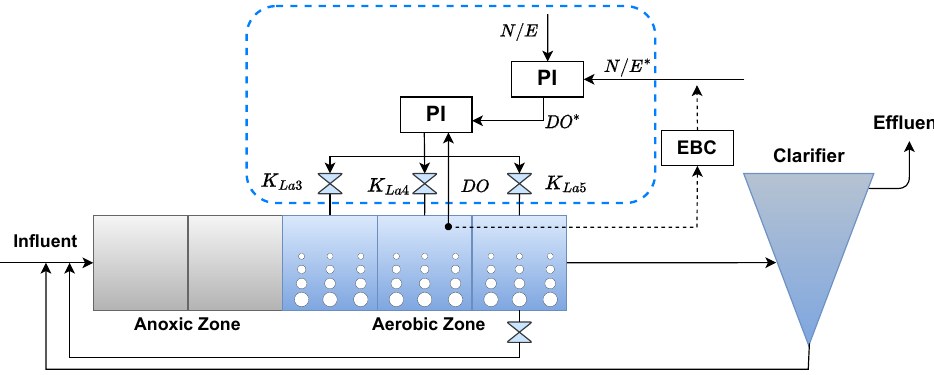
Figure 7. Diagram illustrating the proposed methods in from